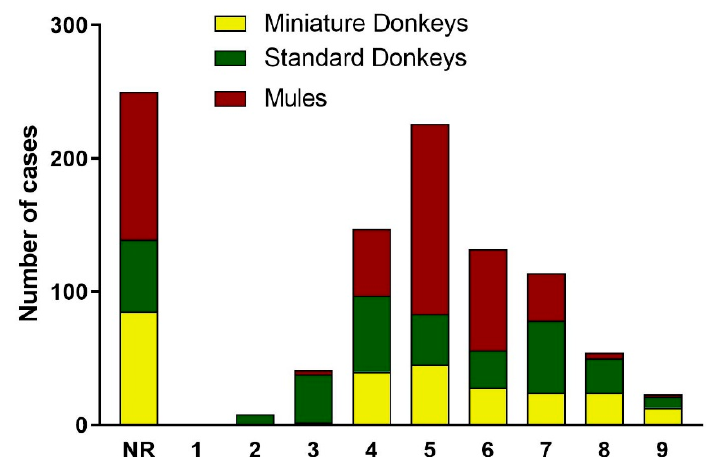
Figure 7. Distribution of the Body Condition Scores for Donkey and Mule Caseload from 2008 to 2017. NR = Not reported in the medical record. Standard donkeys (green), miniature donkeys (yellow), and mules (red).